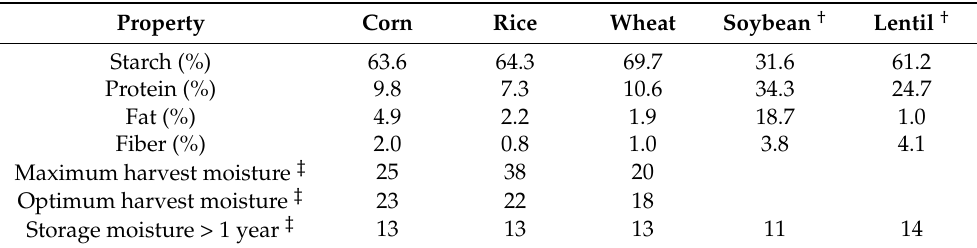
Figure 3. Longitudinal cross-section of corn kernel [98]. Table 1. Constituent properties of corn, rice and wheat obtained at 12–16% moisture content on a wet-basis (wb) and typical harvest and storage moisture